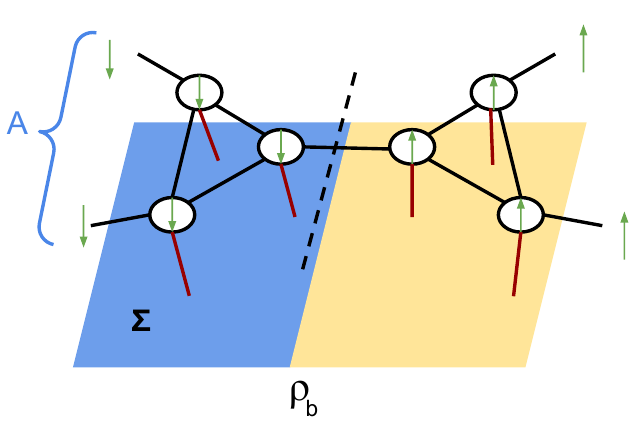
Figure 14. Illustration of the Ising spin con(cid:12)guration for the purity calculation. The boundary condition of the Ising model is de(cid:12)ned as spin down ( s x = (cid:0) 1) for sites in A and up (+1) elsewhere. The link states j xy i contribute a ferromagnetic coupling, and the bulk QFT state (cid:26) b contributes an extra term to the action, given by the second Renyi entropy of the spin down region (cid:6). When a single Ising con(cid:12)guration dominates, the boundary of the spin down domain is the quantum extremal surface